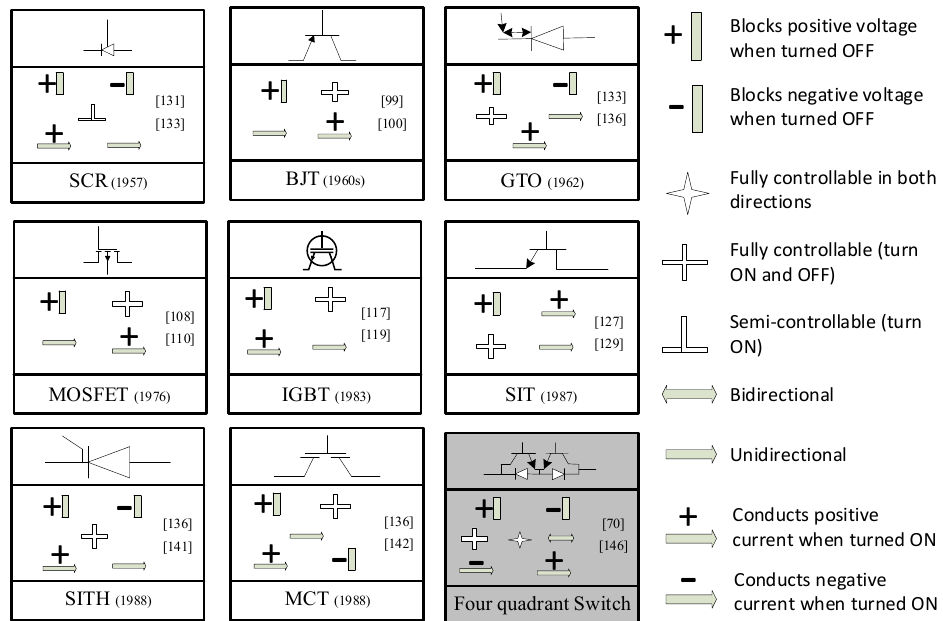
Figure 16. Comparison of some of the prominent power electronic switches for their controllability and ideal V - I characteristics.